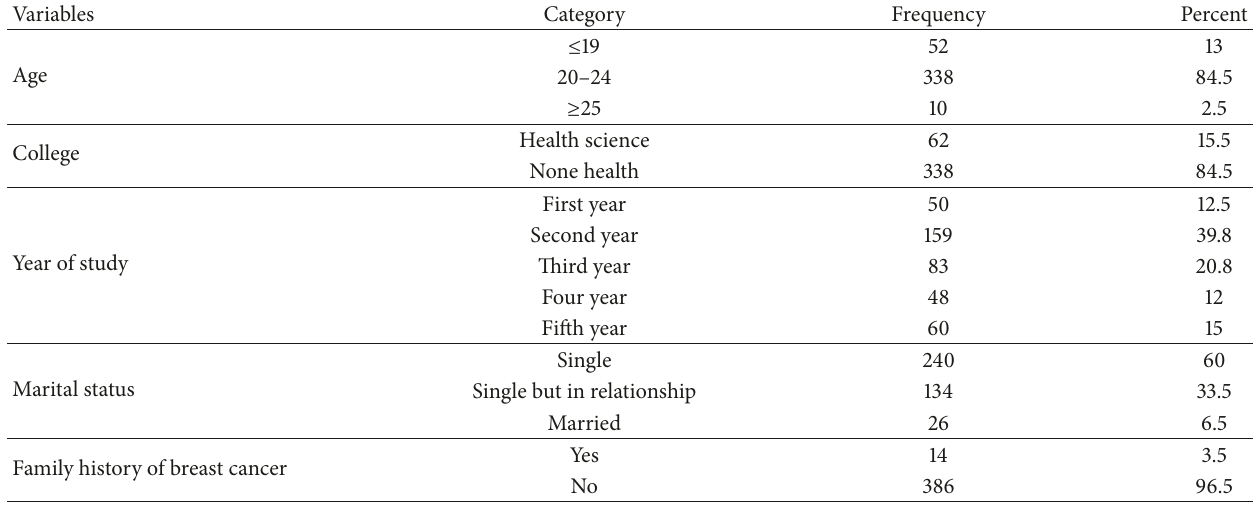
Table 1: Sociodemographic characteristics of the study